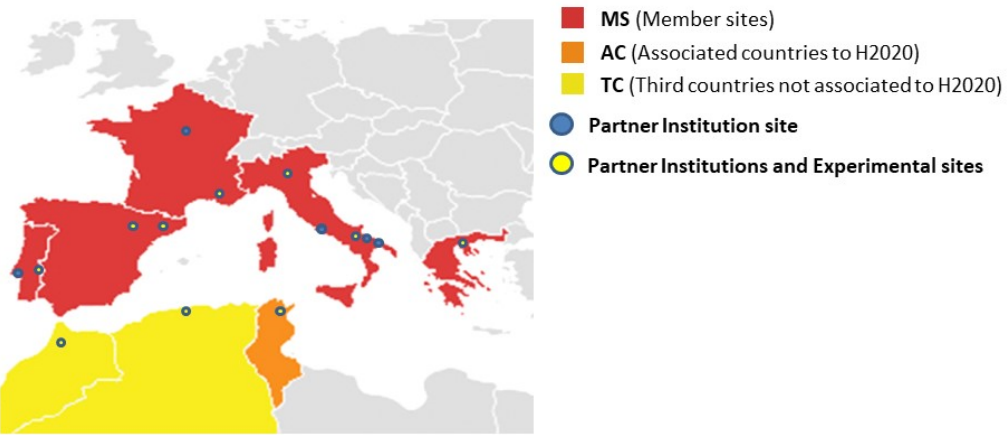
Figure 3. Map of countries and experimental fields involved in the CAMA project.